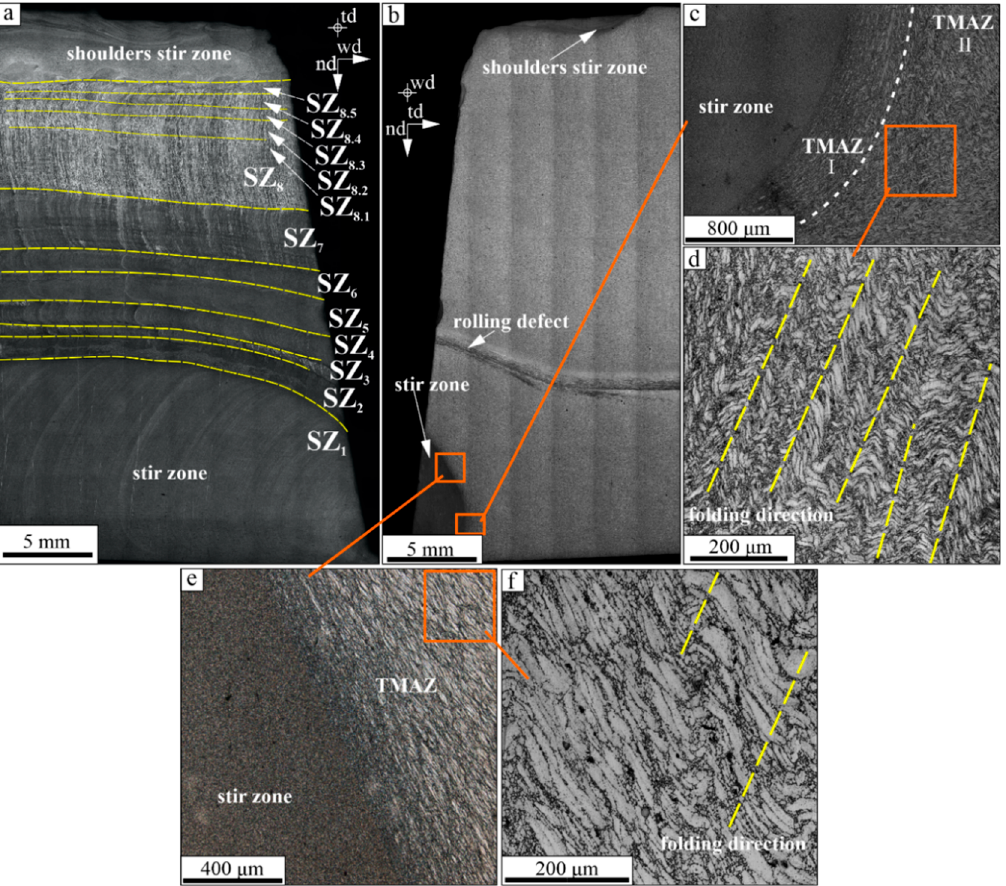
Figure 4. Macrostructures in the FSW tool exit zone as viewed from the plane parallel to the welding direction and perpendicular to the sheet’s surface: ( a ) trailing part of the exit hole, sample 4.2; ( b ) the exit hole on the advancing side of the weld under different magnifications ( c , e ); kinked TMAZ grains in the top ( f ) and bottom ( d ) parts, respectively.